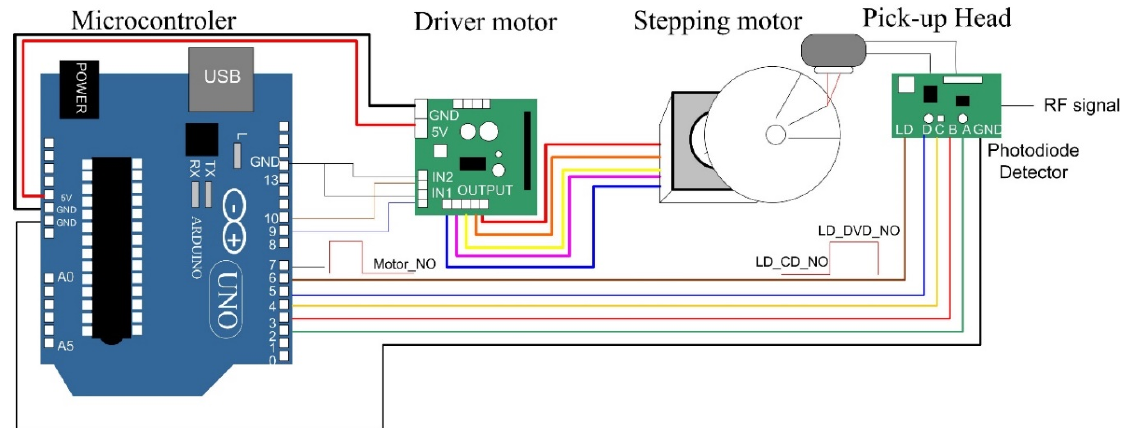
Figure 4. A designed schematic diagram of the microcontroller to control the rotating stepping mo- tor and pick-up heads. and pick-up